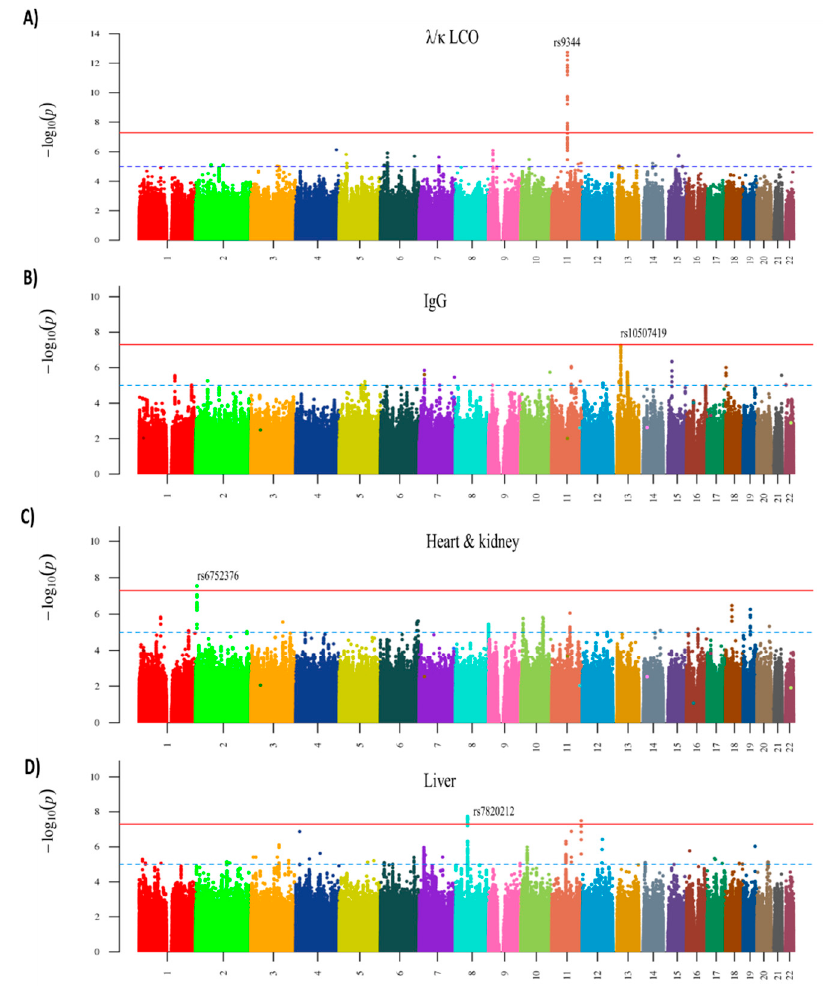
Figure 3. Manhattan plots of association analysis for AL amyloidosis clinical profiles with genome- wide significant results. ( A ) λ / κ LCO profile; ( B ) IgG profile; ( C ) heart and kidney profile; ( D ) liver profile. The x-axis shows the chromosomal position and the y-axis is the significance (–log 10 P; 2- tailed) of association derived by logistic regression. The red line shows the genome-wide significance level (5 × 10 − 8 ) and the blue line shows a suggestive significance level (1 × 10 − 5 ). The top SNP of each significant association is labeled. From reference [26] with permission.